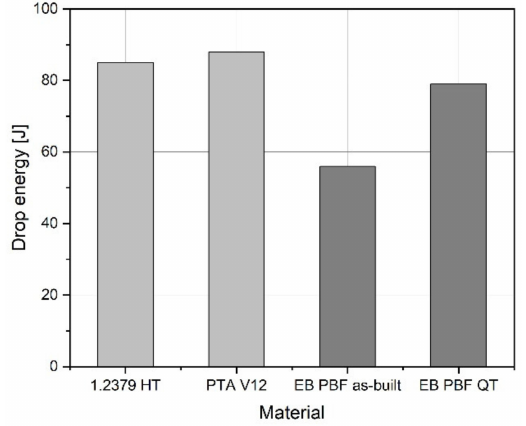
Figure 12. Drop energy dependent on